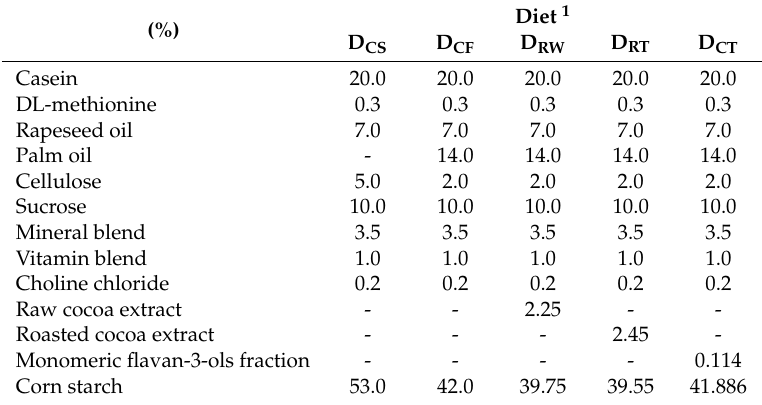
Table 6. Composition of the experimental